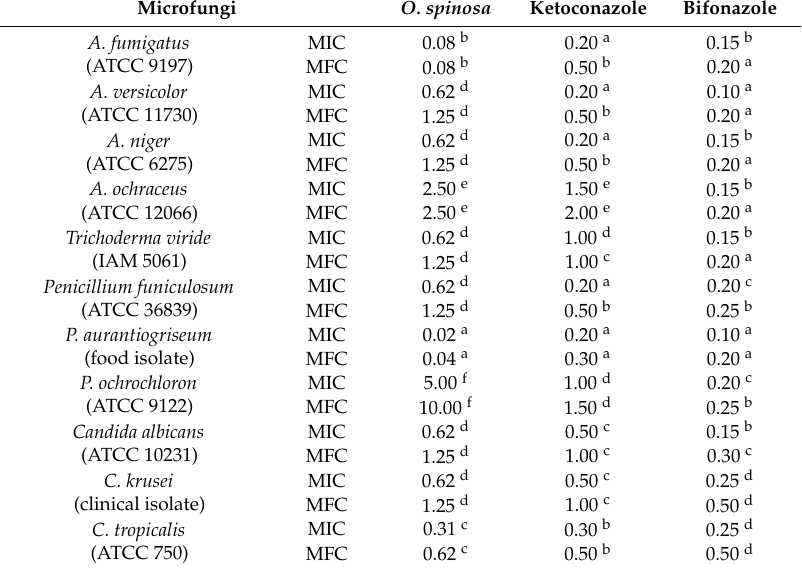
Table 2. Antifungal activities of O. spinosa methanolic extract (MIC (minimum inhibitory concentration) and MFC (minimum fungicidal concentration) mg /